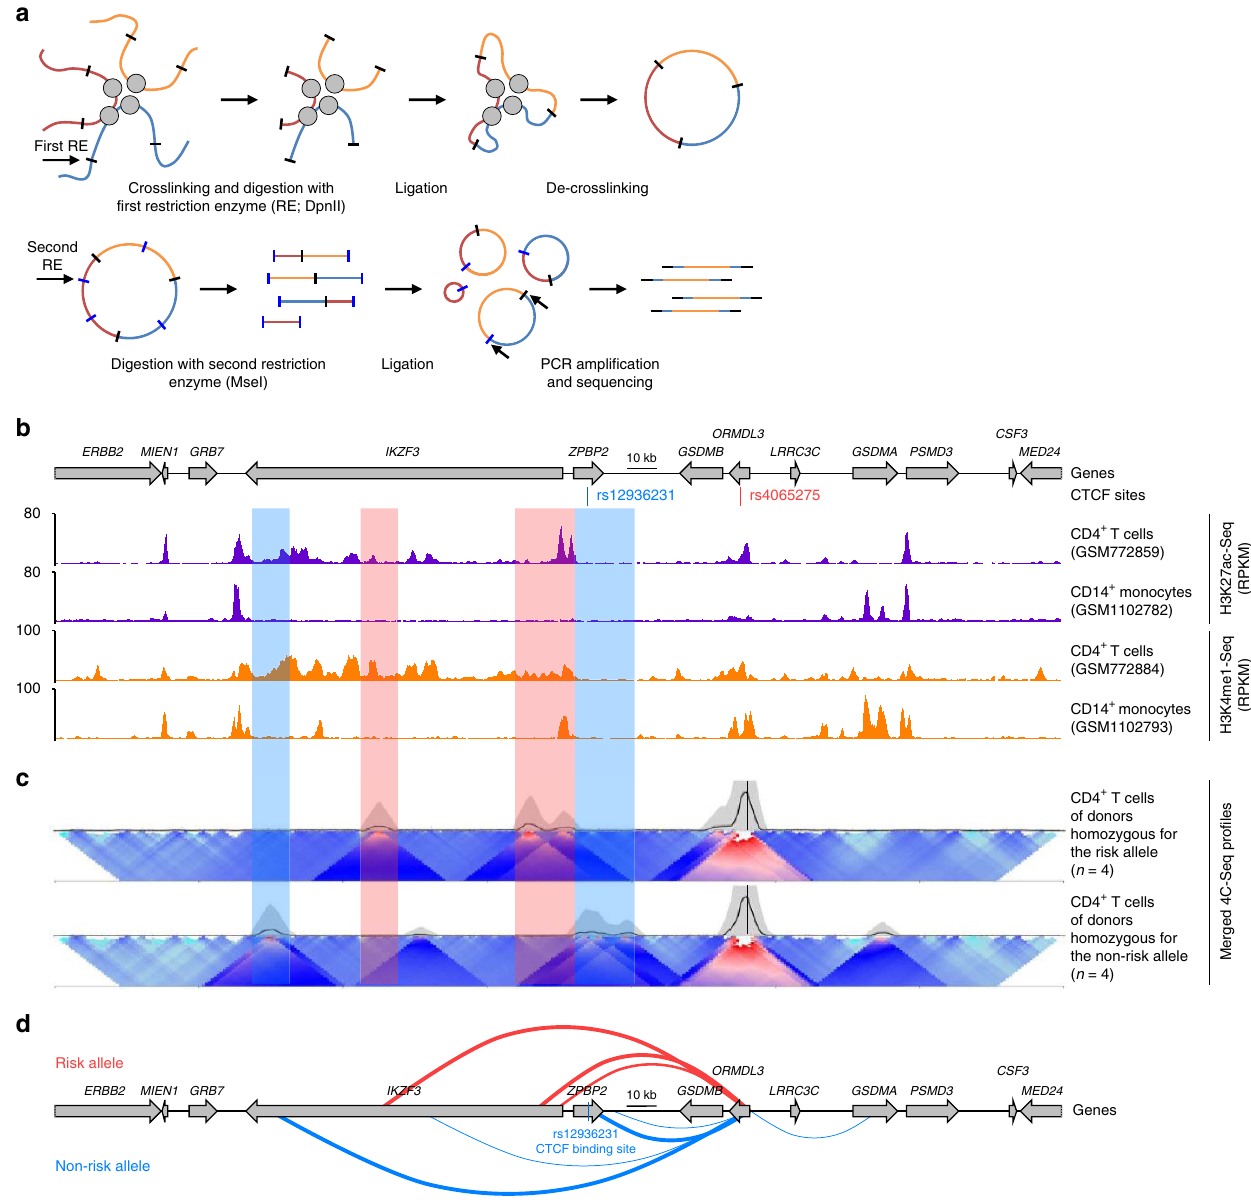
Figure 5 | Asthma-risk SNPs modify long-range ORMDL3 promoter-enhancer interactions. ( a ) Schematic representation of the 4C-Seq assay and the choice of restriction enzymes used for various steps. ( b ) UCSC gene tracks of 17q21 locus (chr17: 37,849,238 - 38,189,238 (hg19); 340kb) showing the CTCF-binding sites that overlap with the linked SNPs rs12936231 (C/G; ZPBP2 site) and rs4065275 (G/A; ORMDL3 site), along with H3K27ac and H3K4me1 enrichment tracks of CD4 þ Tcells and CD14 þ monocytes. ( c ) Merged 4C-Seq domainograms, using colour-coded intensity values to indicate relative levels of interactions (red denotes the strongest interactions and dark blue to turquoise representing gradually decreasing frequencies), generated using 4Cseqpipe 40 (see Methods) are displayed for CD4 þ T cells from subjects homozygous for the risk ( n ¼ 4) and non-risk alleles ( n ¼ 4); the bait region ( ORMDL3 promoter) is marked as a black line. Shaded boxes highlight regions that interact with the bait region at the ORMDL3 promoter in the risk and non-risk alleles (shown in red and blue colour, respectively). ( d ) Schematic representation of the DNA regions interacting with the ORMDL3 promoter in the asthma-risk (red colour) and non-risk alleles (blue colour), the CTCF-binding site in the ZPBP2 region of the non-risk alleles in shown as a blue